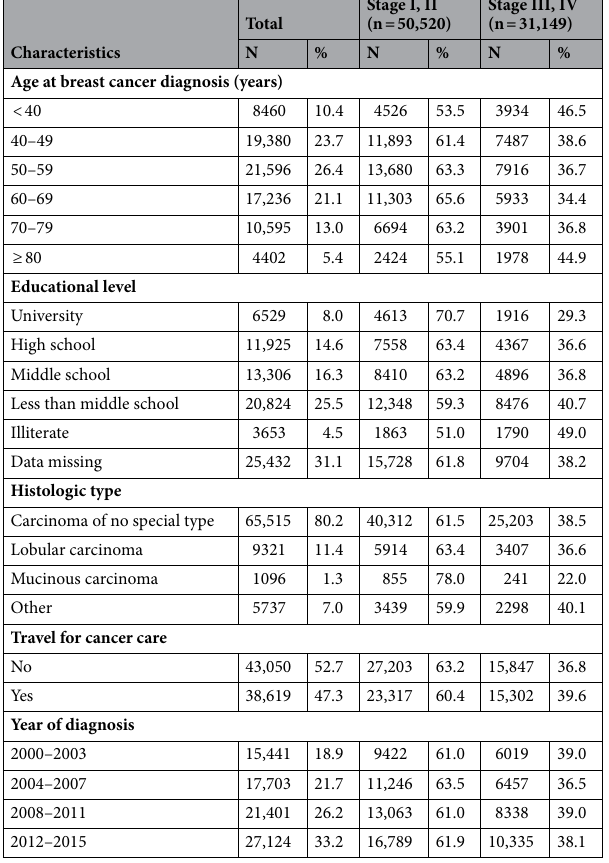
Table 1. Characteristics of female breast cancer diagnosed between 2000 and 2015 and included in the hospital-based cancer registries affiliated to the public health system in the state of São Paulo, Brazil.